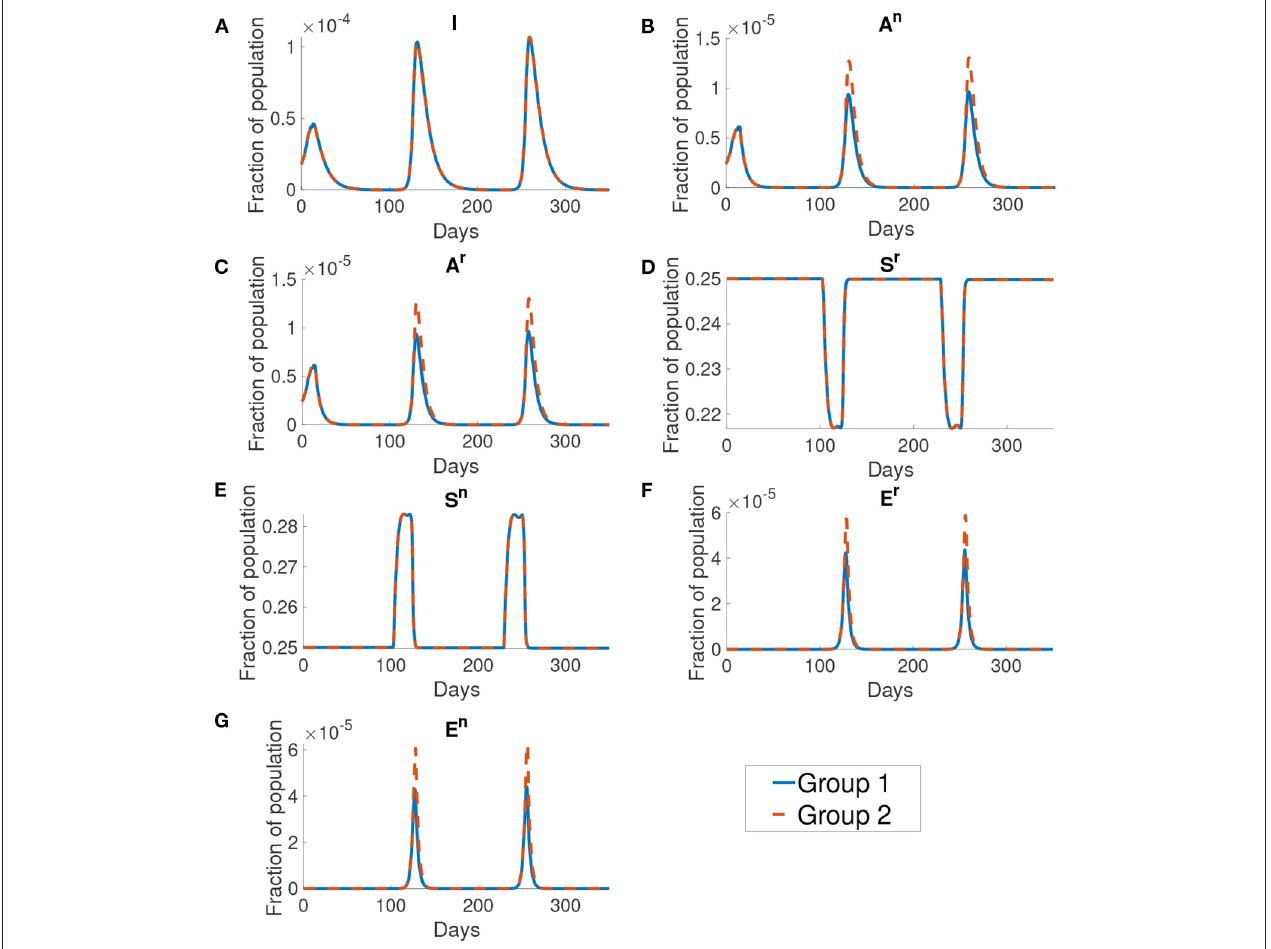
FIGURE 10 | The dynamics of different compartments in the simulation. From figures (A–G) shows the infected population, the normal asymptomatic population, the reduced asymptomatic population, the reduced susceptible population, the normal susceptible population, the reduced exposed population and the normal exposed population. The blue curve shows the fraction of population for group 1 and the orange curve shows the fraction of population of group 2. We can see that the group 1 and group 2 are the same except at the normal asymptomatic and the normal exposed population.